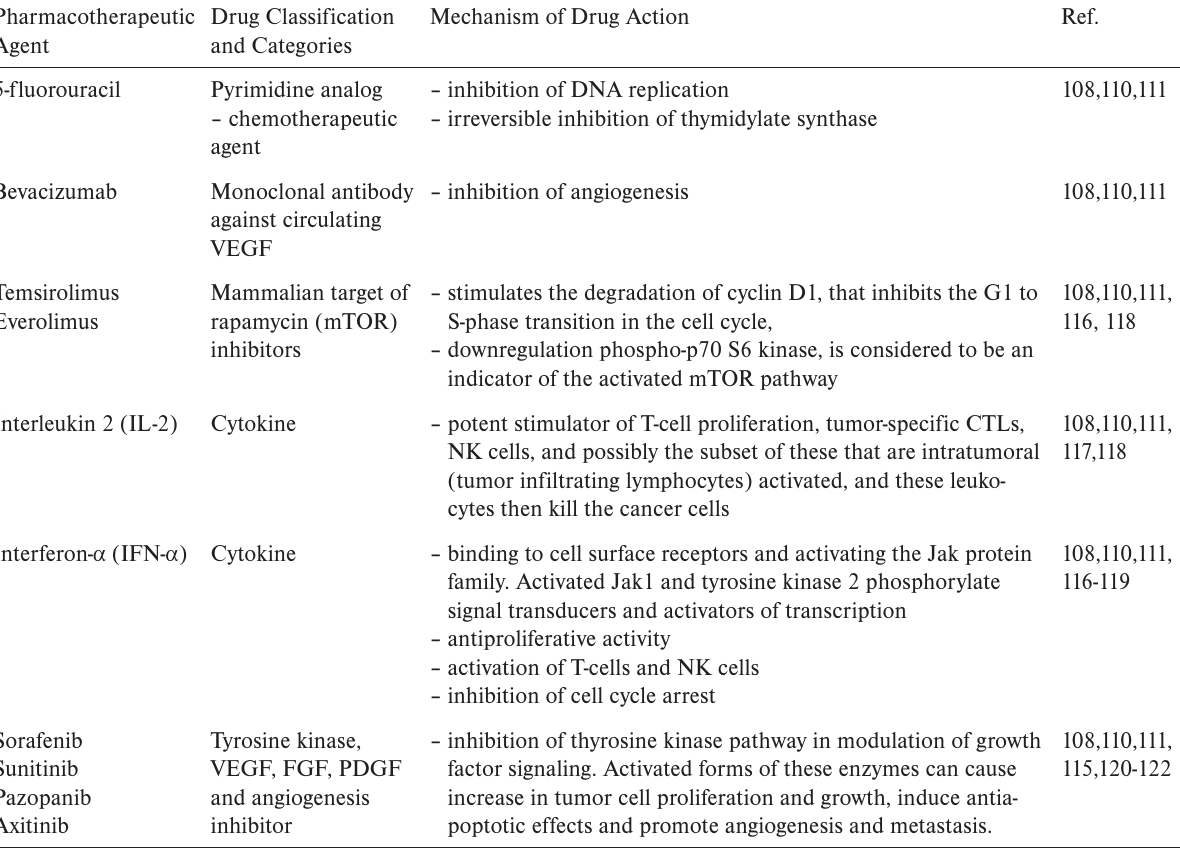
Table 3. Pharmacotherapeutic agents for systemic therapy in patients with metastatic RCC